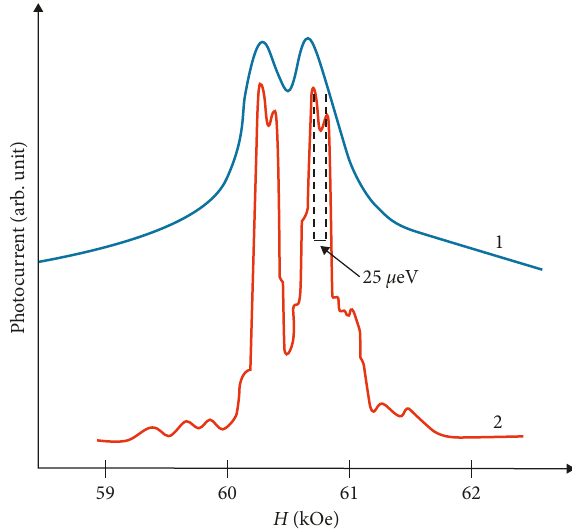
Figure 4: Shape of the 1s ⟶ 2p + 1 line of n-GaAs sample 6 at the radiation energy of E � 14 . 7 meV and T � 4 . 2K, K � 0 . 5 for (1) ε < ε in the constant field regime and (2) ε ≈ ε in the constant BD BD current regime at J � 17 μ A. The PES lines are strongly narrowed at Figure 5: Photoelectric spectra of n-GaAs samples at the radia- the breakdown, the fine structure of each line and new lines with smaller intensities appear at the tails of the main tion energy E � 10 . 45 meV and T � 4 . 2K for (1) ε < ε ε ≈ ε . BD